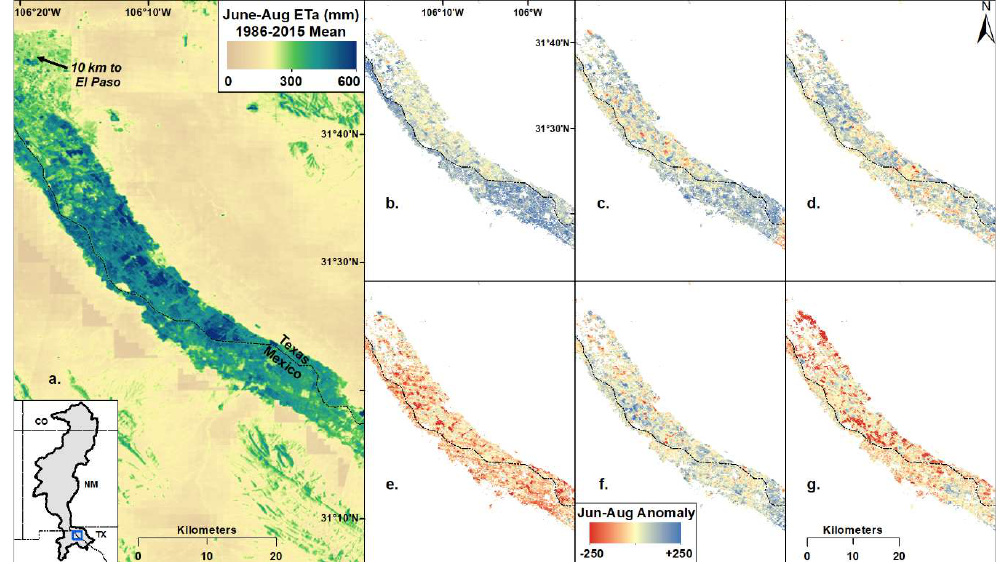
Figure 8. Texas and Mexico June–August ETa showing ( a ) 1986–2015 mean ETa (mm), and the annual anomaly (deviation from the mean, mm) on a 5-year interval for ( b ) 1990, ( c ) 1995, ( d ) 2000, ( e ) 2005, ( f ) 2010, and ( g ) 2015.